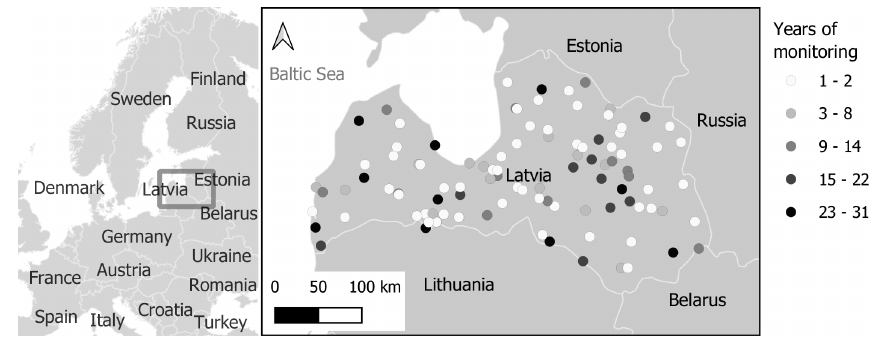
Figure 4. Site and observation point locations and quantity of available data; duration given in